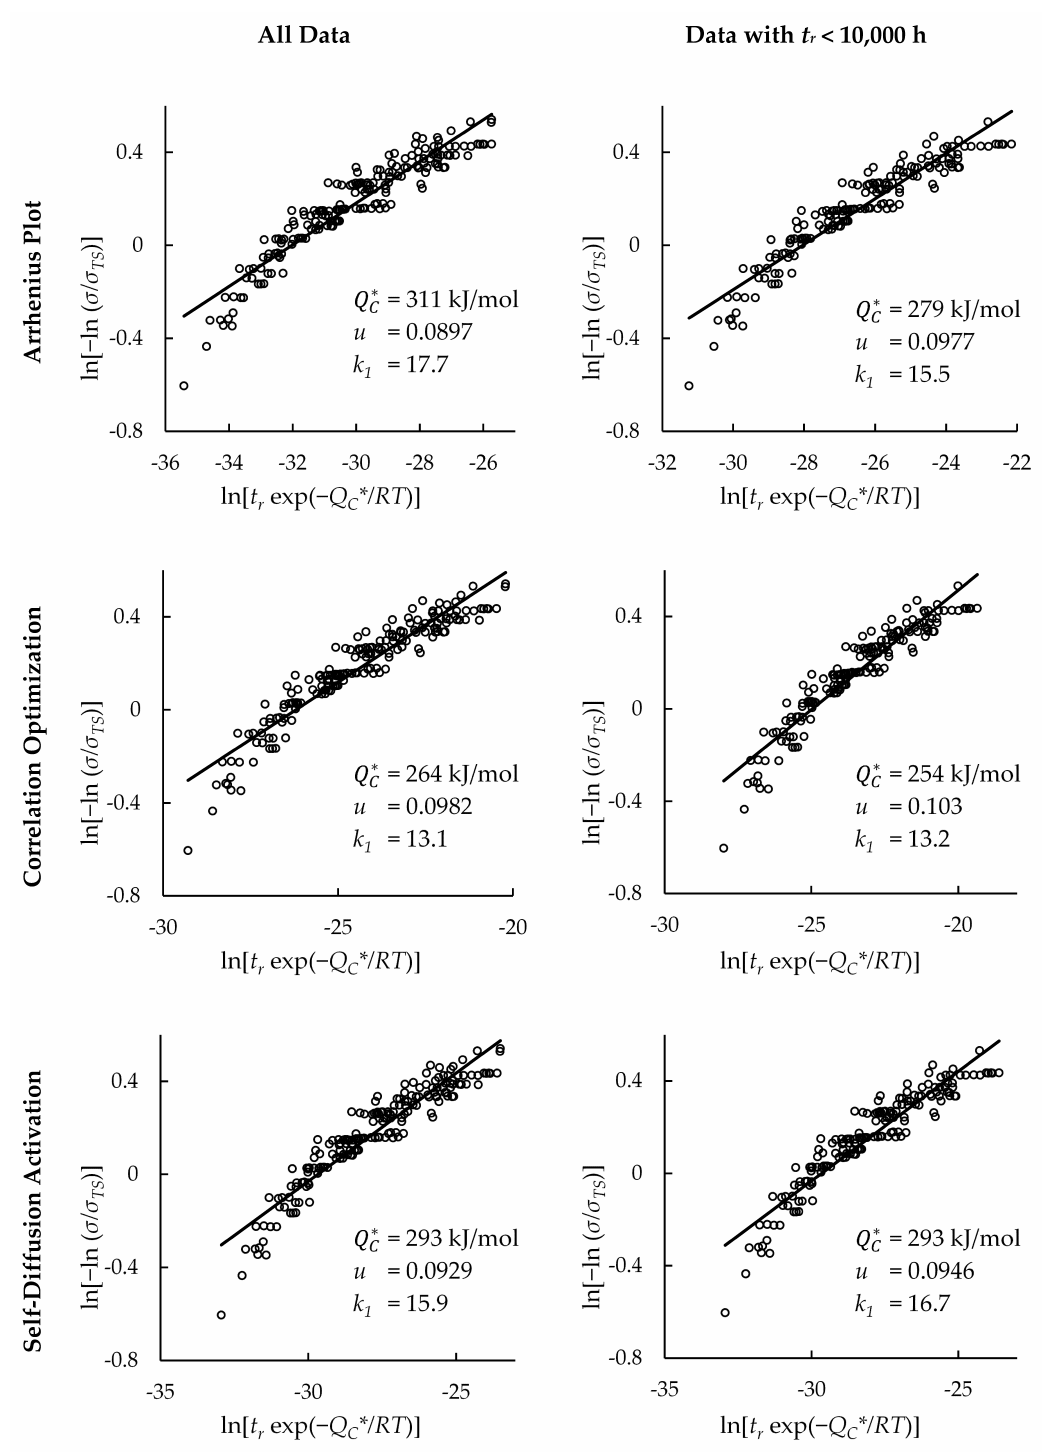
Figure A1. Goodness of fit of HR6W creep rupture data on Wilshire plots.